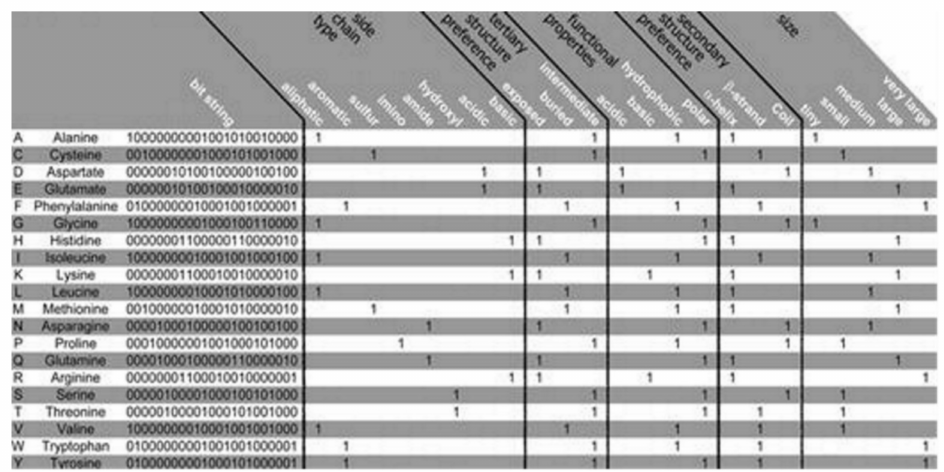
Figure 2. Amino acid properties. The Bit string that represents the amino acids with 23 properties has been presented. The relative occurance frequency got converted into corresponding binary values with the aid of the majority vote. Regarding ‘size’ all of the amino acids got categorized considering the molecular weights: tiny, small, medium, large, and very large for ≤ 71 Da, ≤ 103 Da, ≤ 115 Da, ≤ 137 Da, and >137 Da,